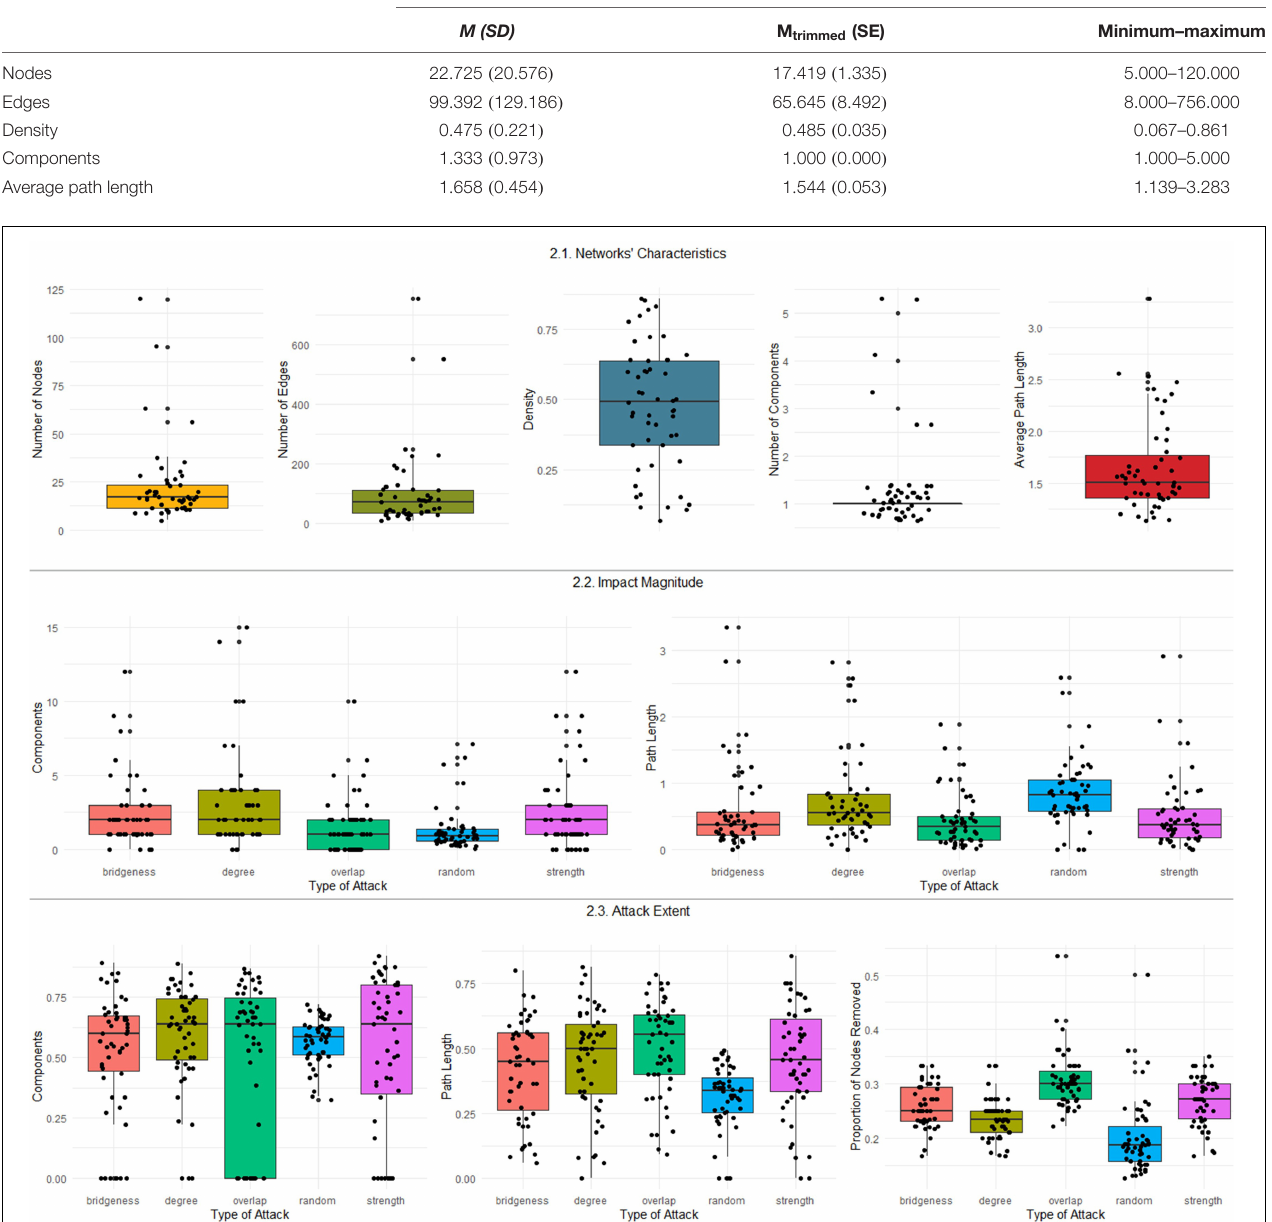
FIGURE 2 | Boxplots summarizing the distributions of the network characteristics, impact magnitude, and attack extent.